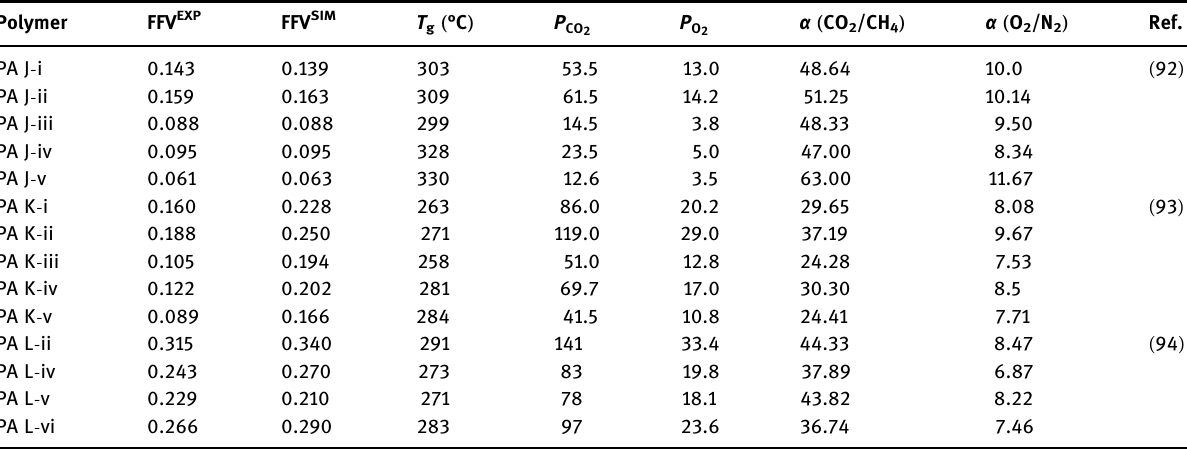
Table 10: FFV, T g , and gas permeability ( in Barrers ) and permselectivity values of the TPA containing PAs measured at 35°C and 3.5 bar pressure